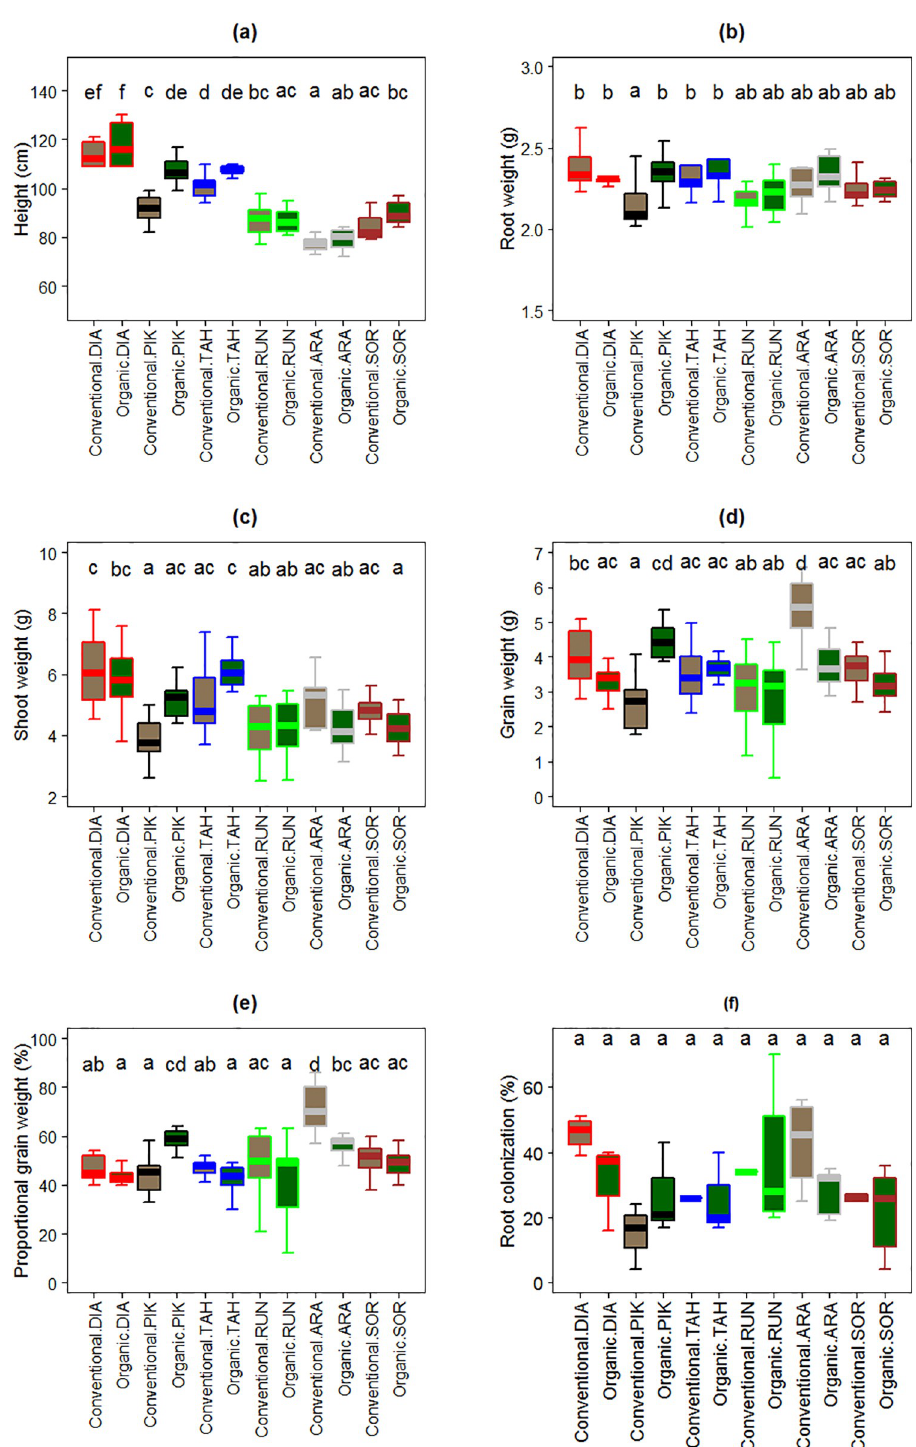
Fig 4. Effect of the interaction between inoculum type (soil from conventionally or organically managed field) and wheat cultivar on plant traits: Height (a), root weight (b), shoot weight (c), grain weight (d), proportional grain weight (e), and root colonization (f). Fig 4f probably exaggerates the impression of differences, given that many bars represent 1–3 points. Thick lines represent medians; boxes indicate interquartile ranges; and whiskers show maximum and minimum values per sample. DIA: Diamant: 1929, PIK: Pikker 1959, TAH: Ta¨hti 1972, RUN: Runar 1972, ARA: Arabella 2012, SOR: Sorbas 2016.